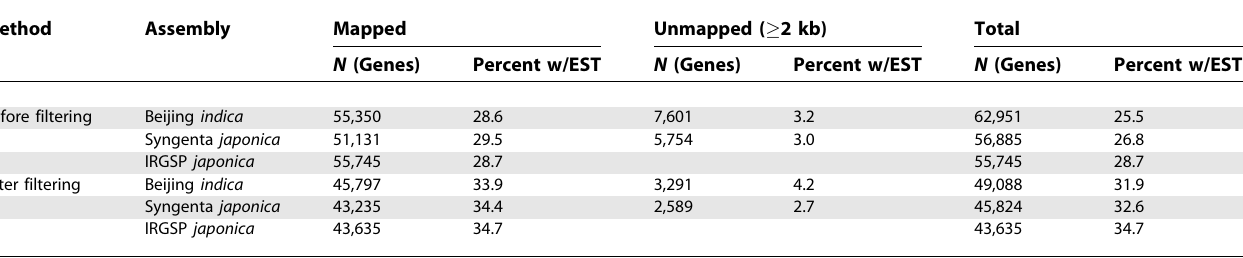
Table 3. Number of FGENESH Predictions in All Three Rice Assemblies Method Assembly